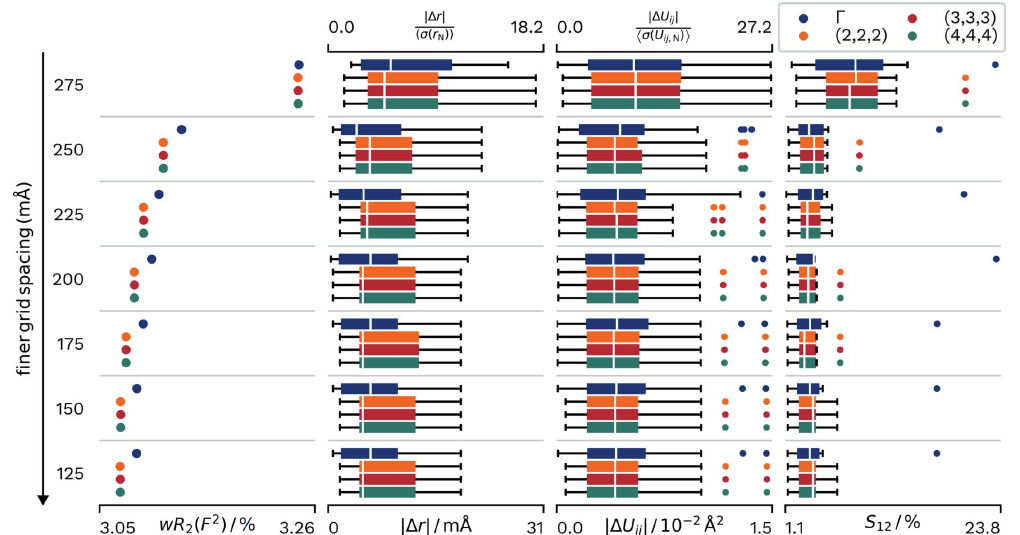
Figure 2 Differences in wR 2 ( F 2 ) and agreement with neutron values for different real-space grid spacings and different samplings of the reciprocal space. Distributions of parameters are displayed as box-whisker plots. Different horizontal groups correspond to the real-space grid spacing for the wavefunction calculation, which is interpolated once for the density evaluation and interpolated another time for the calculation of atomic form factors via FFT. The four differently coloured sets within this group correspond to the different k -point